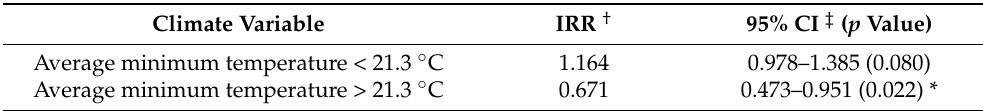
Table 5. Results of the piecewise analysis and incidence rate ratio between minimum temperature and dengue